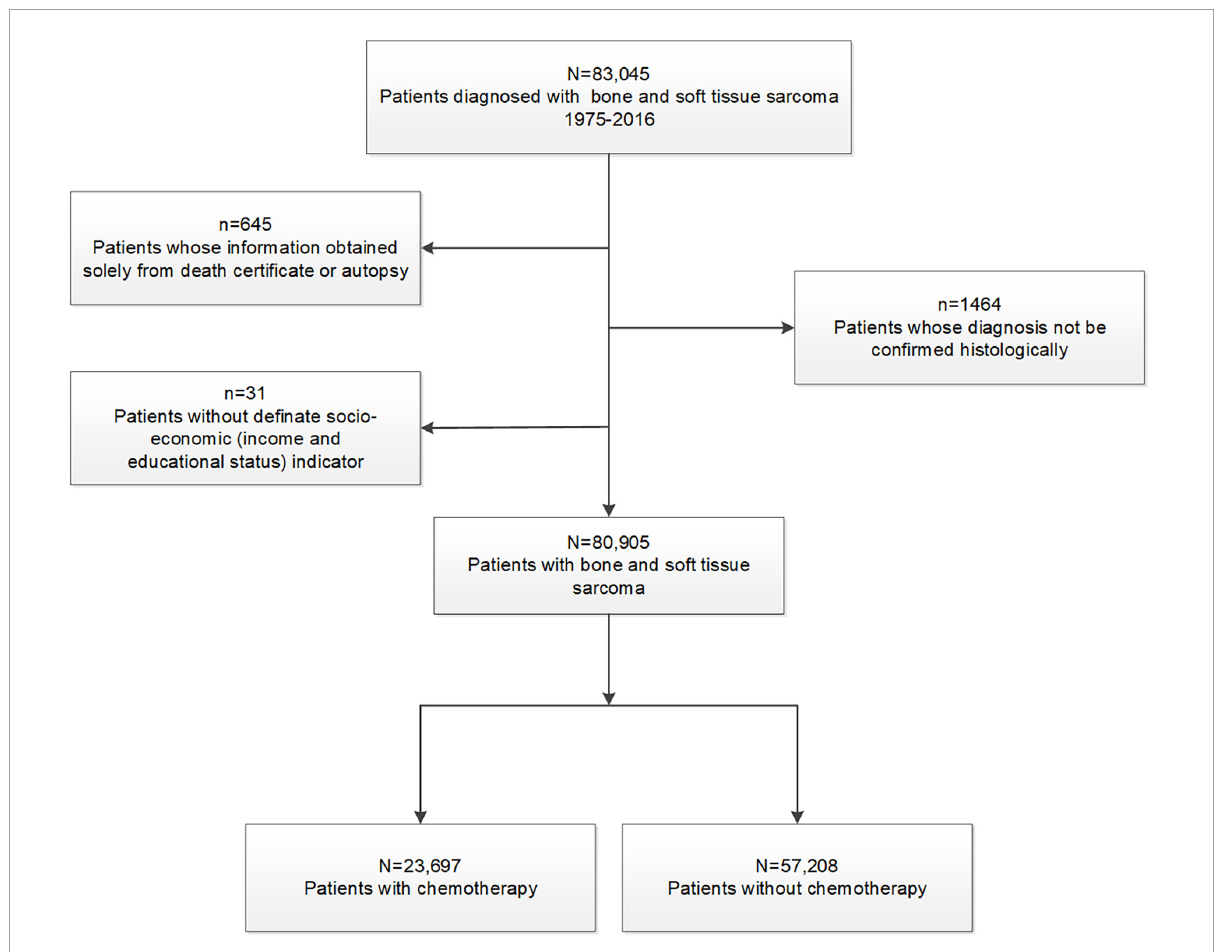
FIGURE1 Flowchart describing initial dataset and exclusions leading to final study